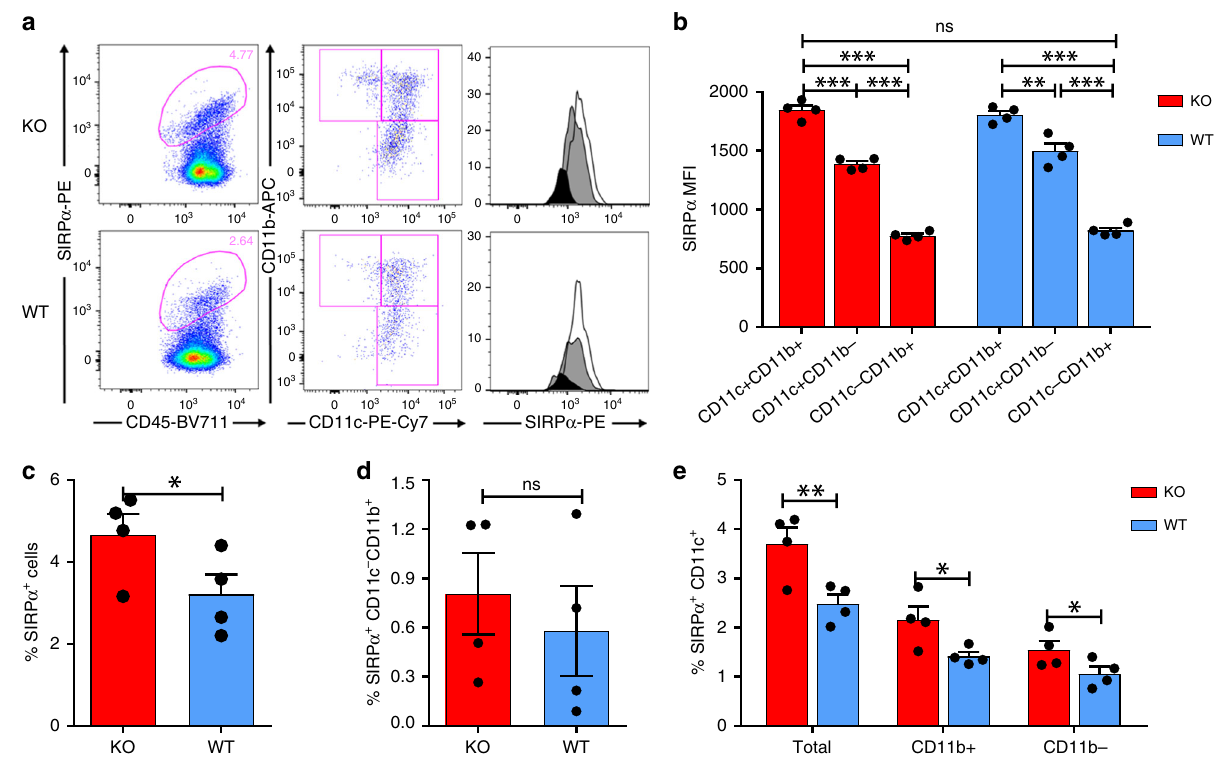
Fig. 4 Phenotypes of SIRP α + cells and levels of SIRP α expression. Spleen cells harvested 24 h after vaccination with 2.5 × 10 6 irradiated WT or CD47KO B16F0 cells were analyzed for SIRP α expression on various cell populations by fl ow cytometry. a Representative fl ow cytometry pro fi les showing the ratio of SIRP α + cells (left), CD11b and CD11c expression gated SIRP α + cells (middle), and levels of SIRP α expression on gated CD11b + CD11c + DCs (open histogram), CD11b − CD11c + DCs (gray shaded histogram) and CD11b + CD11c − myeloid cells (black shaded histogram; right). b MFI of SIRP α expression on the indicated cell populations. ** p < 0.01; *** p < 0.005 (one-way ANOVA). c Percentages of total SIRP α + cells. d Percentages of SIRP α + CD11b + CD11c